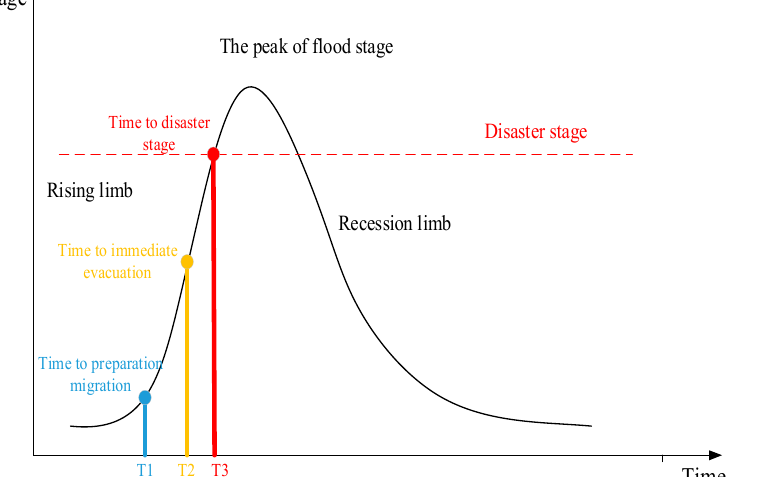
Figure 9. The three critical times for early flood warning.